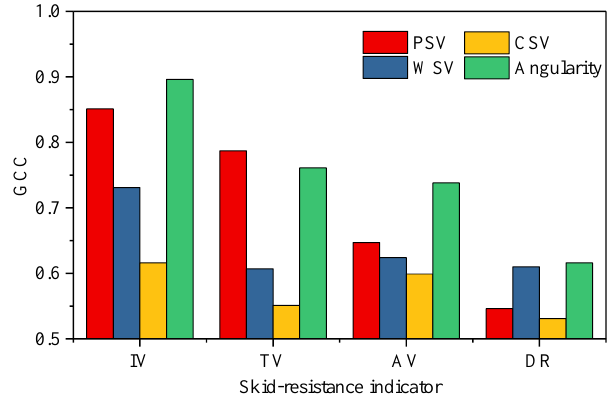
Figure 8. GCC between aggregate properties and skid-resistance indicators.